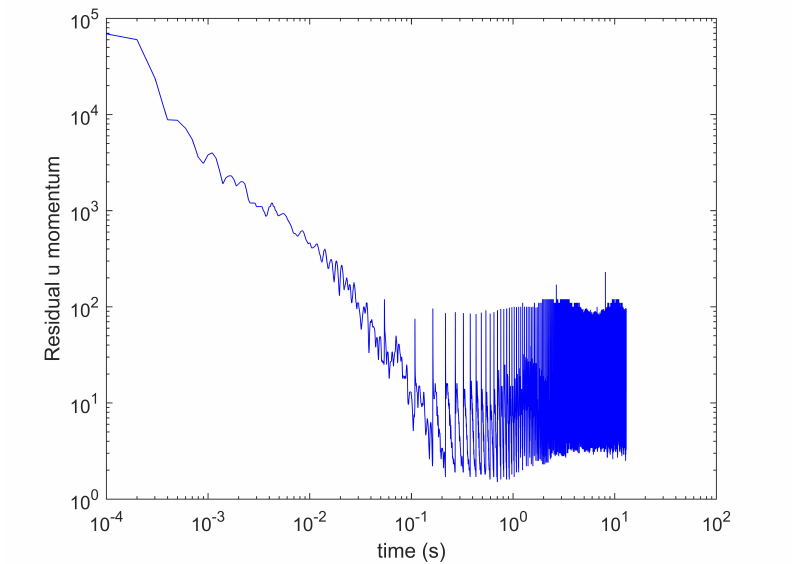
Figure 7. Residual drop over time advance, for the u velocity component momentum